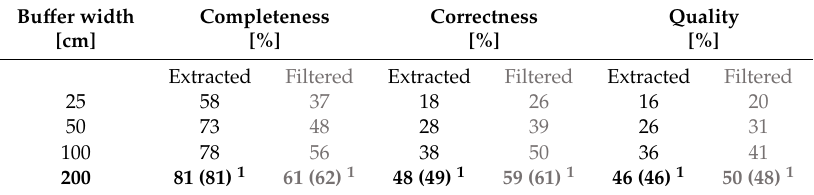
Table 3. Accuracy assessment of boundary extractions for a GSD of 25 cm, scale 80, merge 95.